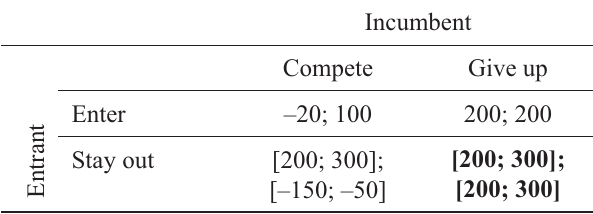
Table 2. The entrance with side payments